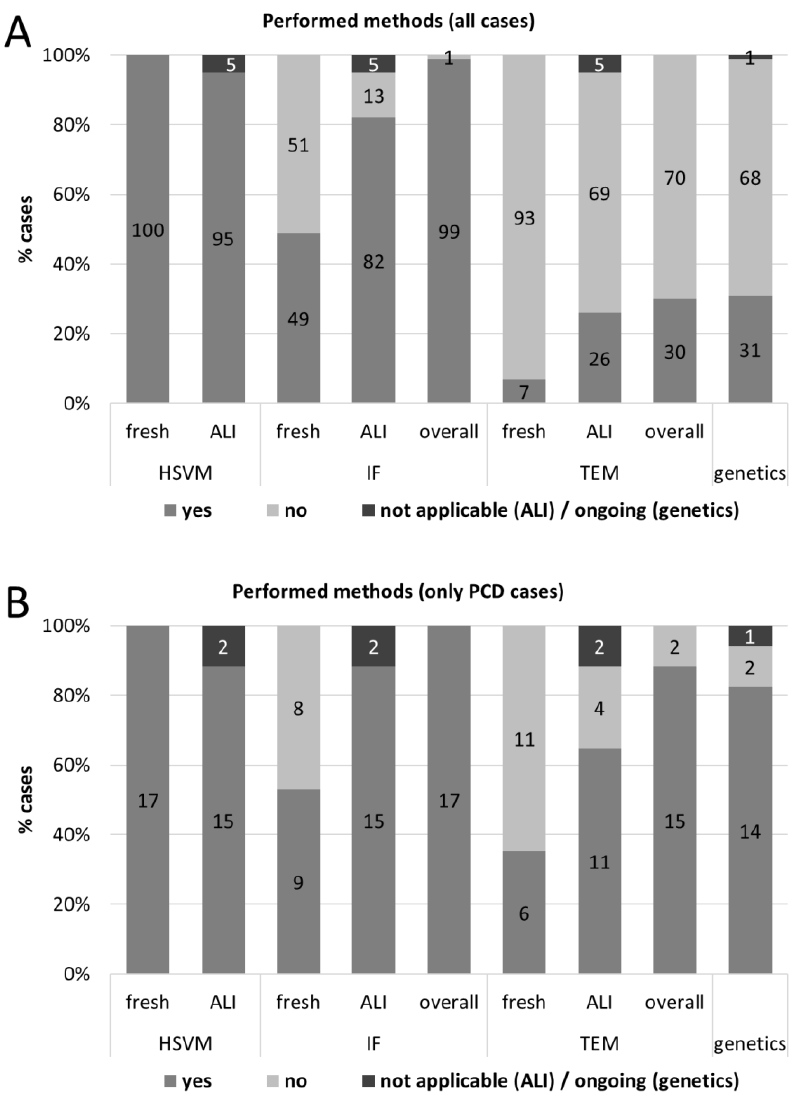
Figure 2. Overview of the performed tests from the first 100 patients ( A ) of the PCD-UNIBE diagnostic center and of PCD cases only ( B ). Numbers in the bars indicate number of cases.